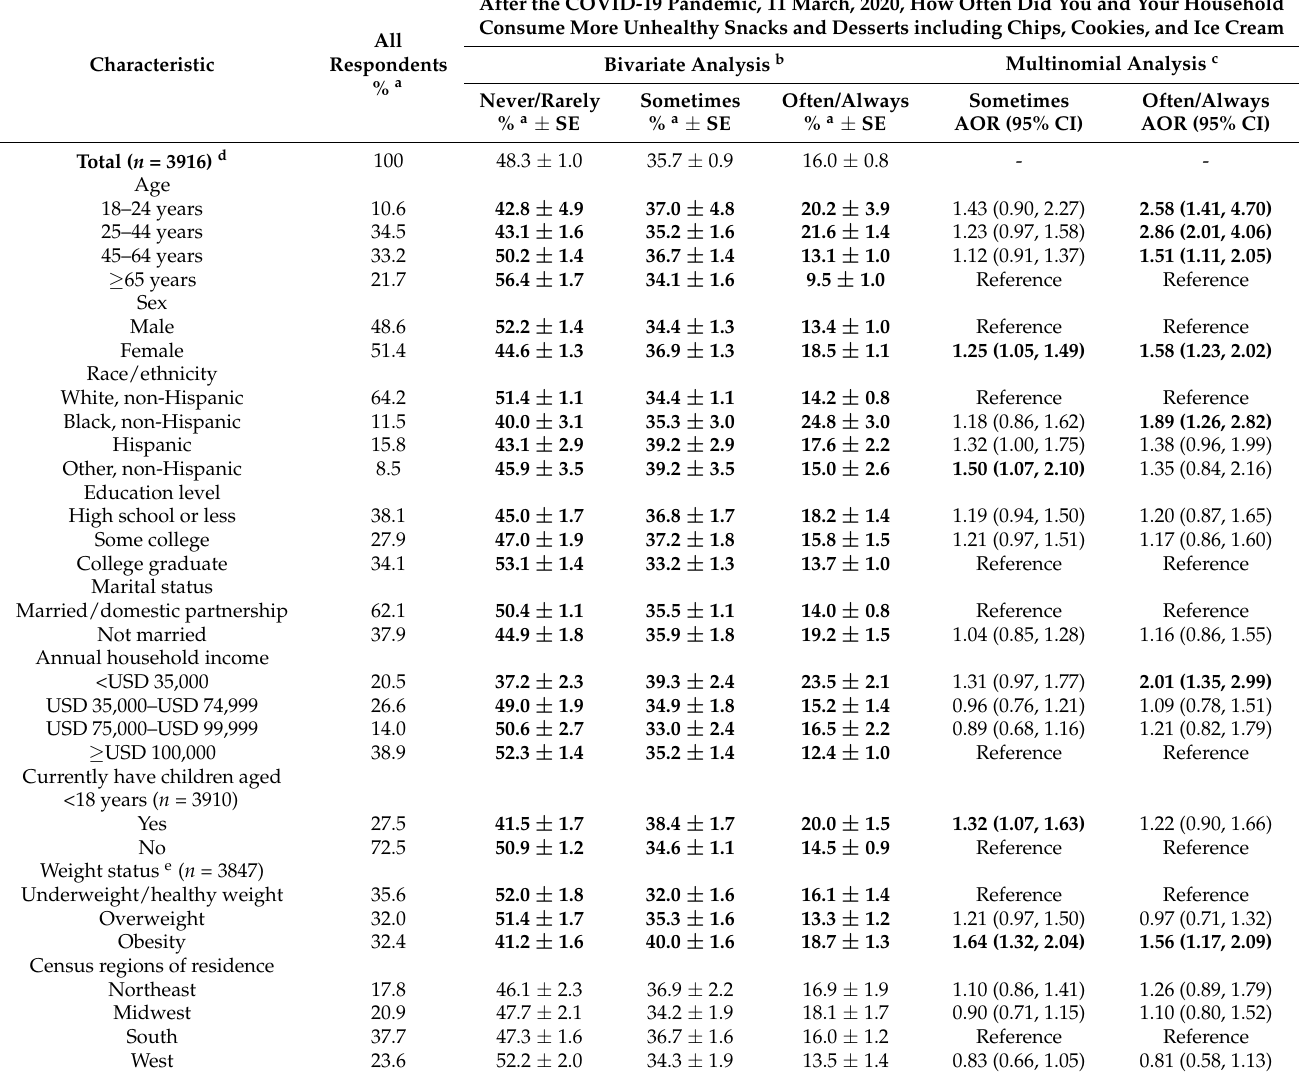
Table 1. Characteristics of respondents and their associations with consuming more unhealthy snacks and desserts including chips, cookies, and ice cream after the COVID-19 pandemic among US adults, SummerStyles Survey,